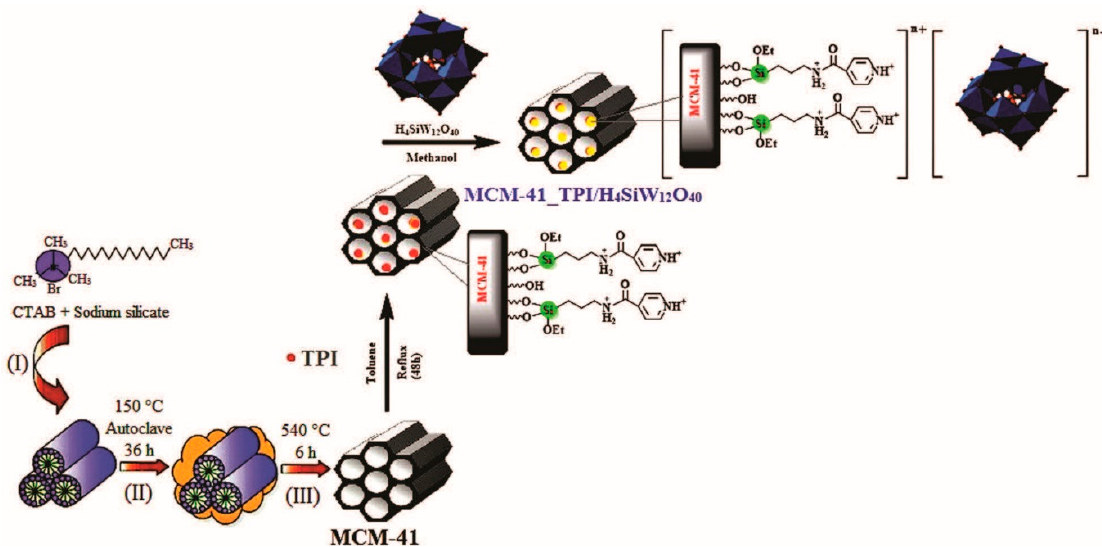
Figure 43. Schematic diagram for the pyridine functionalization of MCM-41 mesoporous silica and immobilization of heteropolyacid (HPA). Reproduced with permission from [81]. Copyright 2015 Royal Society of Chemistry.